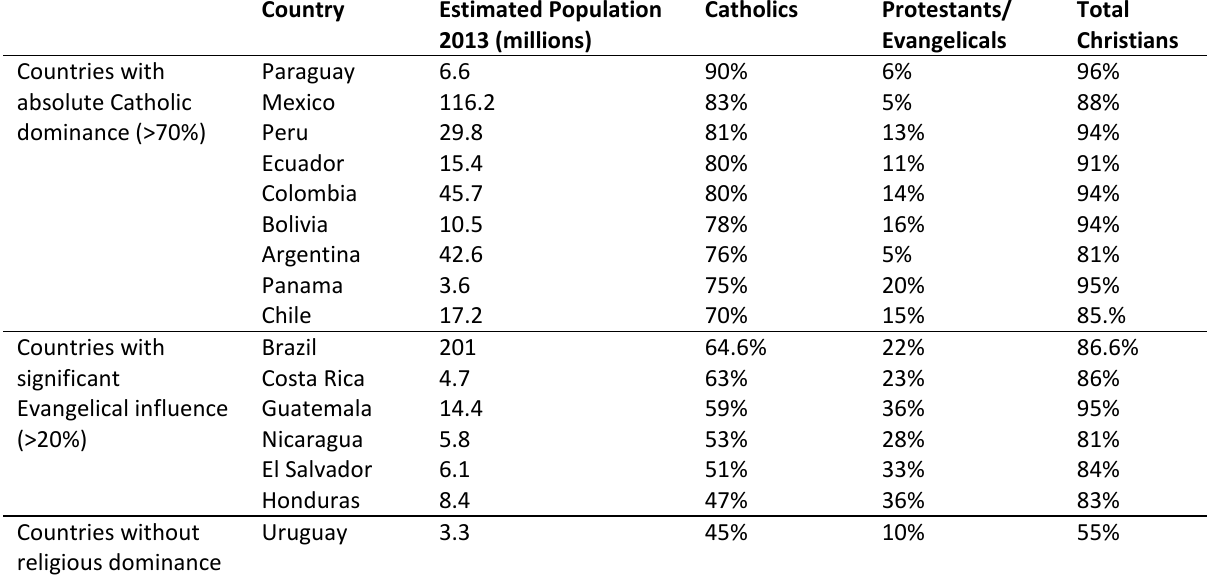
Table 1. Percentage of Catholics and Protestants.